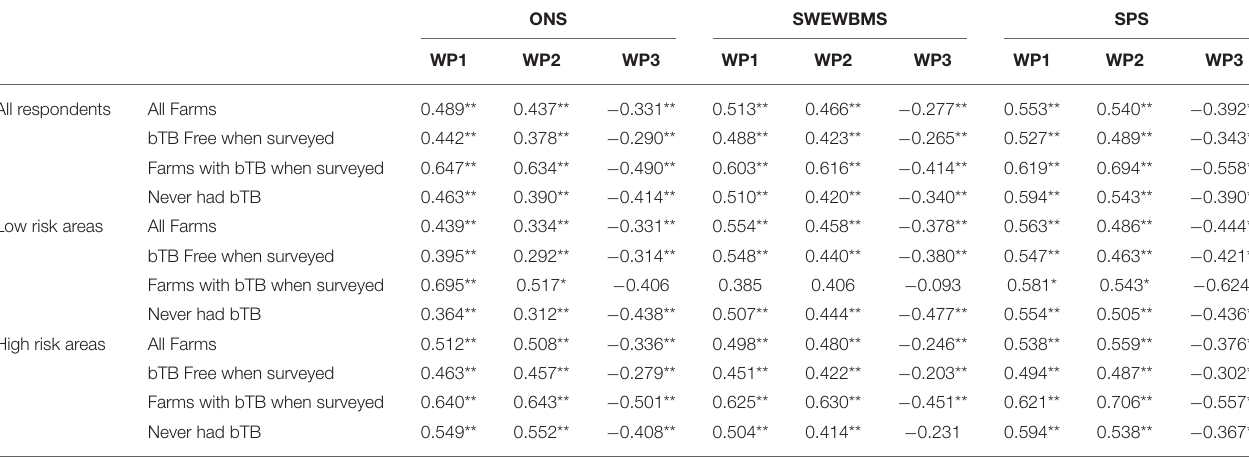
TABLE 8 | Correlation co-efficients between subjective well-being and work productivity measures. ONS